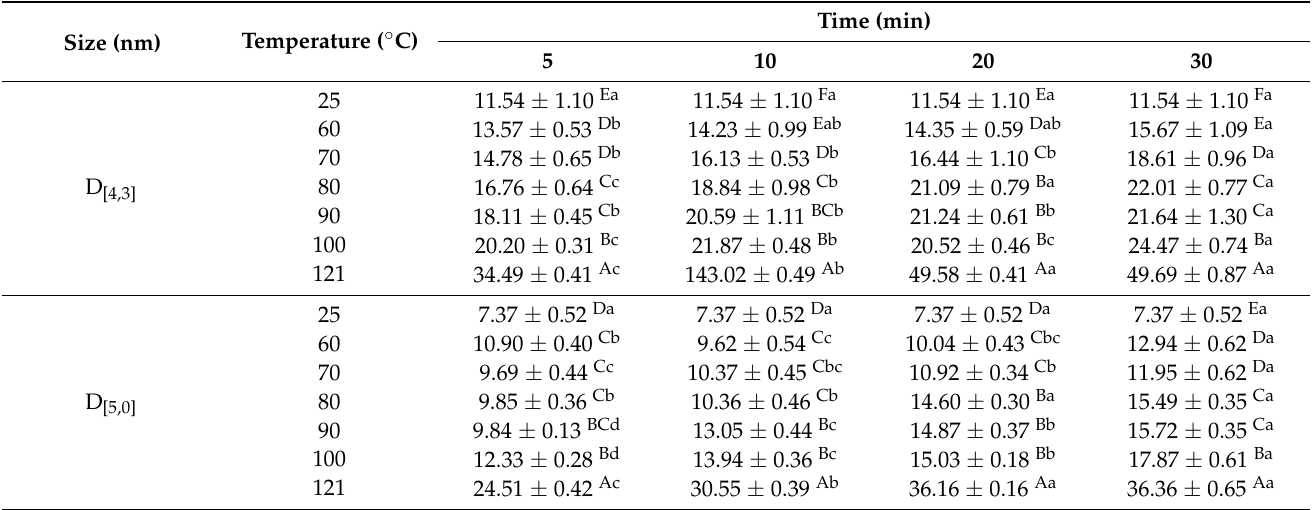
Table 1. Effects of different hydrothermal treatment conditions on D [4,3] and D [5,0] , nm. A–F indicates the significant differences between different temperatures and a–c indicates the significant differences between different times ( p <